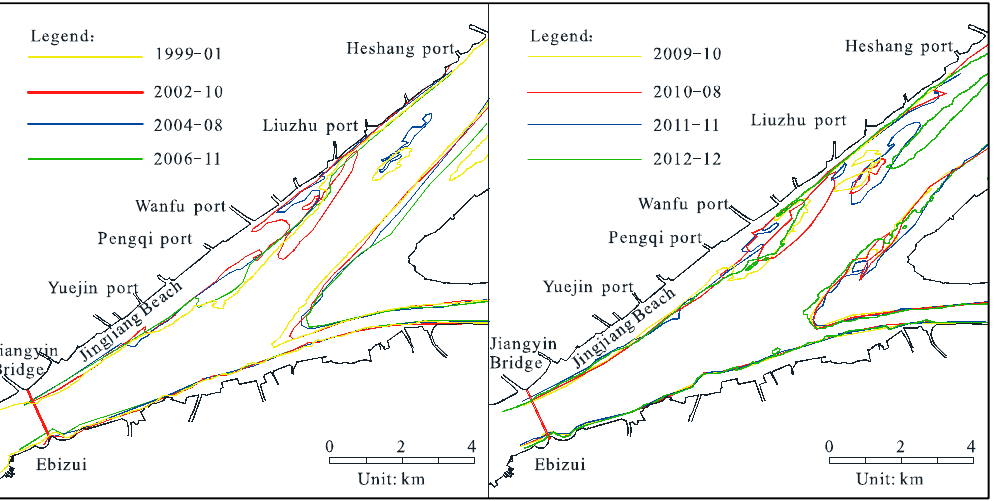
Figure 5. Evolution of the 10 m isobath of Jingjiang Beach under natural condition from 1999 to 2012.